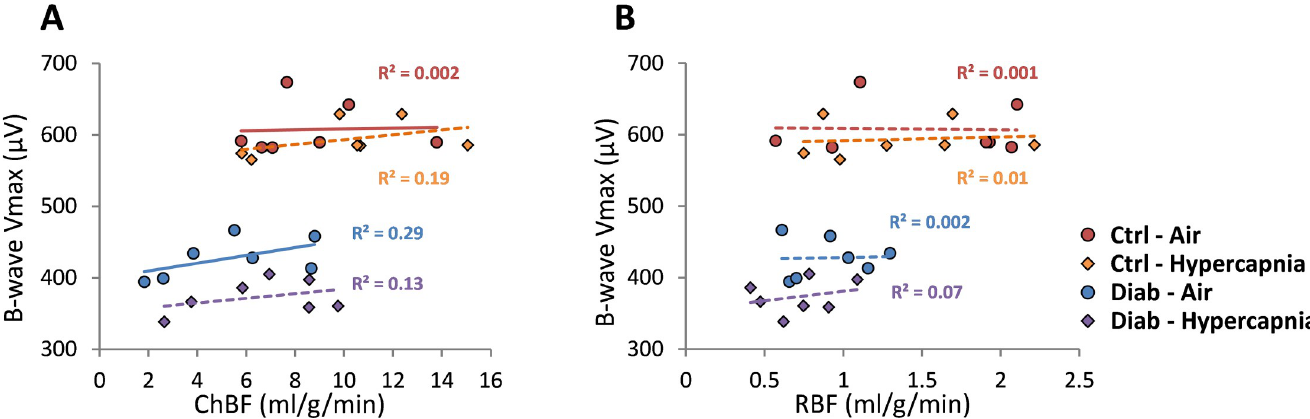
Fig 7. Correlations between ERG b-wave Vmax with ChBF (A) or RBF (B) from the nasal region under regular room air and under hypercapnia for Ctrl and Diab groups. The straight lines are fitted linear regression lines with R 2 values shown.